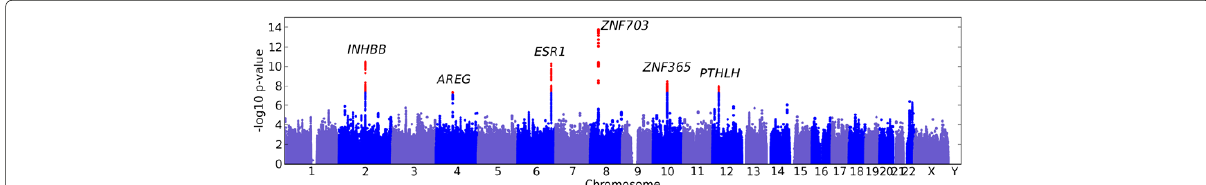
Figure 1 Manhattan plot of association with breast size. − log 10 p -values across all SNPs tested. SNPs shown in red are genome-wide significant ( p < 5 · 10 − 8 ). Regions are named with the postulated candidate gene.